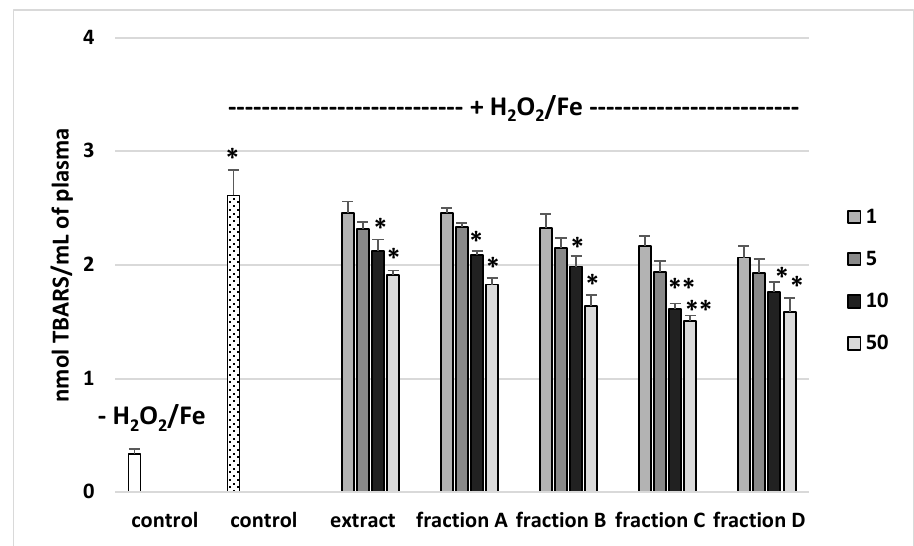
Figure 2. Effects of the extract and the four fractions (A–D, concentration range 1–50 µg/mL, pre-incubation time—5 min) from Paulownia Clone in Vitro 112 leaves on lipid peroxidation in plasma treated with H 2 O 2 /Fe (incubation time—25 min). Results are given as mean ± SEM ( n = 6). Control negative (white bar) refers to plasma not treated with H 2 O 2 /Fe, whereas control positive (dot bar) to plasma treated with H 2 O 2 /Fe. One-way ANOVA followed by a multicomparison Duncan′s test: * p ≤ 0.05, ** p ≤ 0.02, compared with positive control (treated with H 2 O 2 /Fe); * p ≤ 0.05, compared between negative control and positive control.